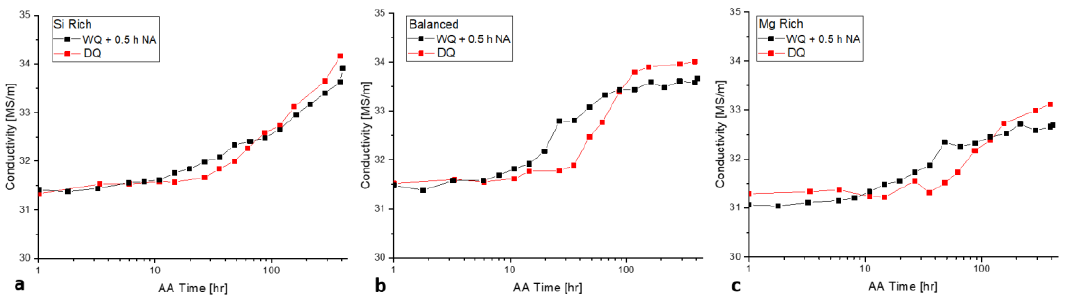
Figure 14. AA hardness evolutions of the low strength alloys in the DQ condition, compared to traditional WQ followed by short (0.5 h) NA, labelled accordingly. Error bars represent 95% confidence.